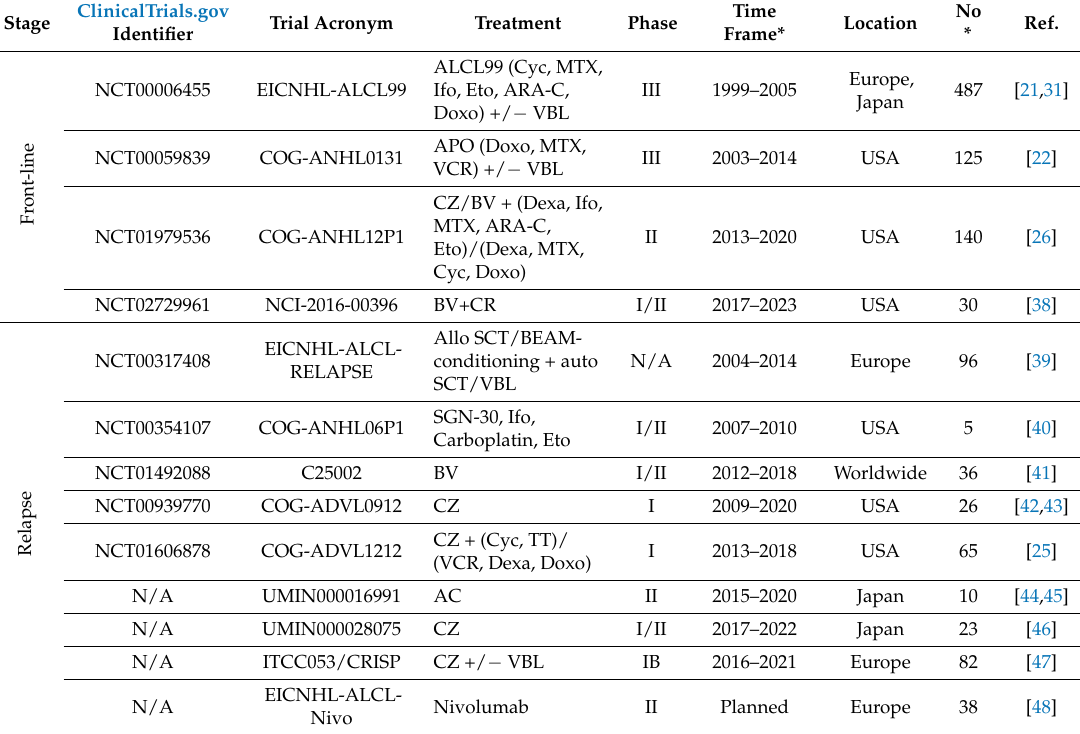
Table 3. Past, ongoing, and planned clinical trials for paediatric ALCL. Allo = allogeneic; AC = alectinib; auto = autologous; BEAM = carbustine, etoposide, cytarabine and melphalan; BV = brentuximab